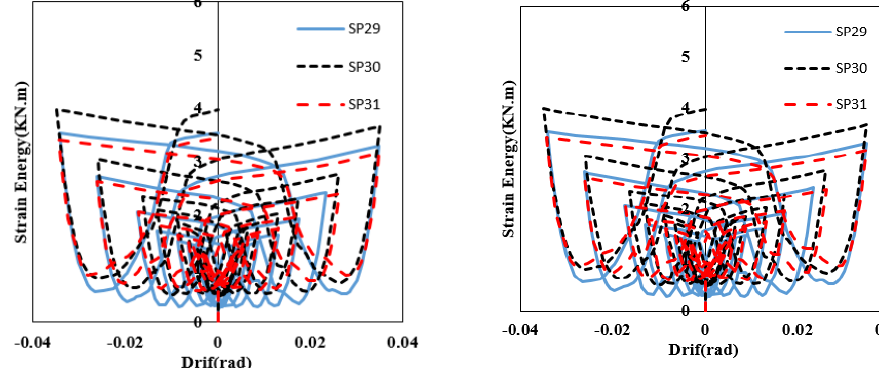
Figure 19. Strain energy and drift.